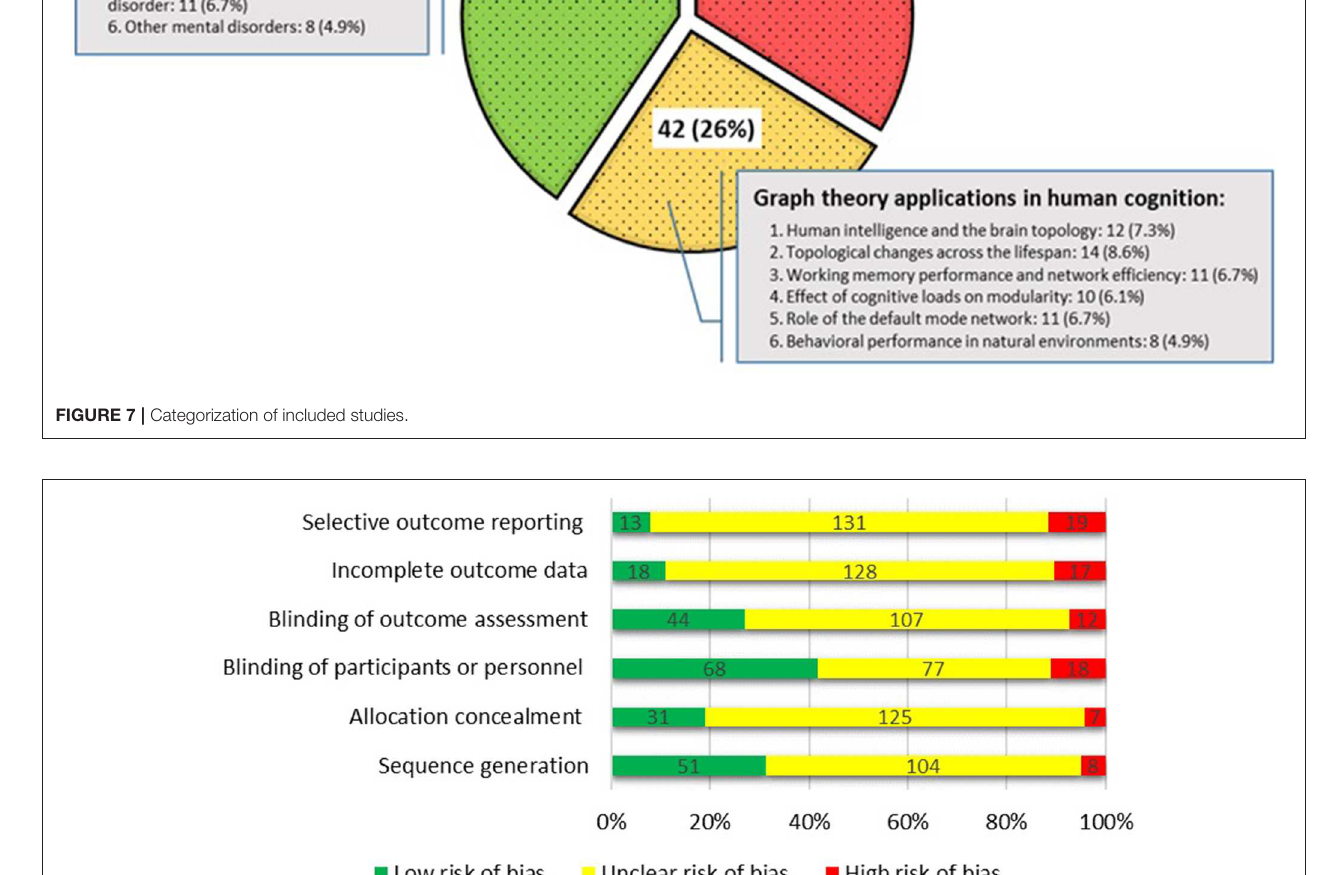
FIGURE 8 | Assessing the risk of bias using the Cochrane collaboration’s